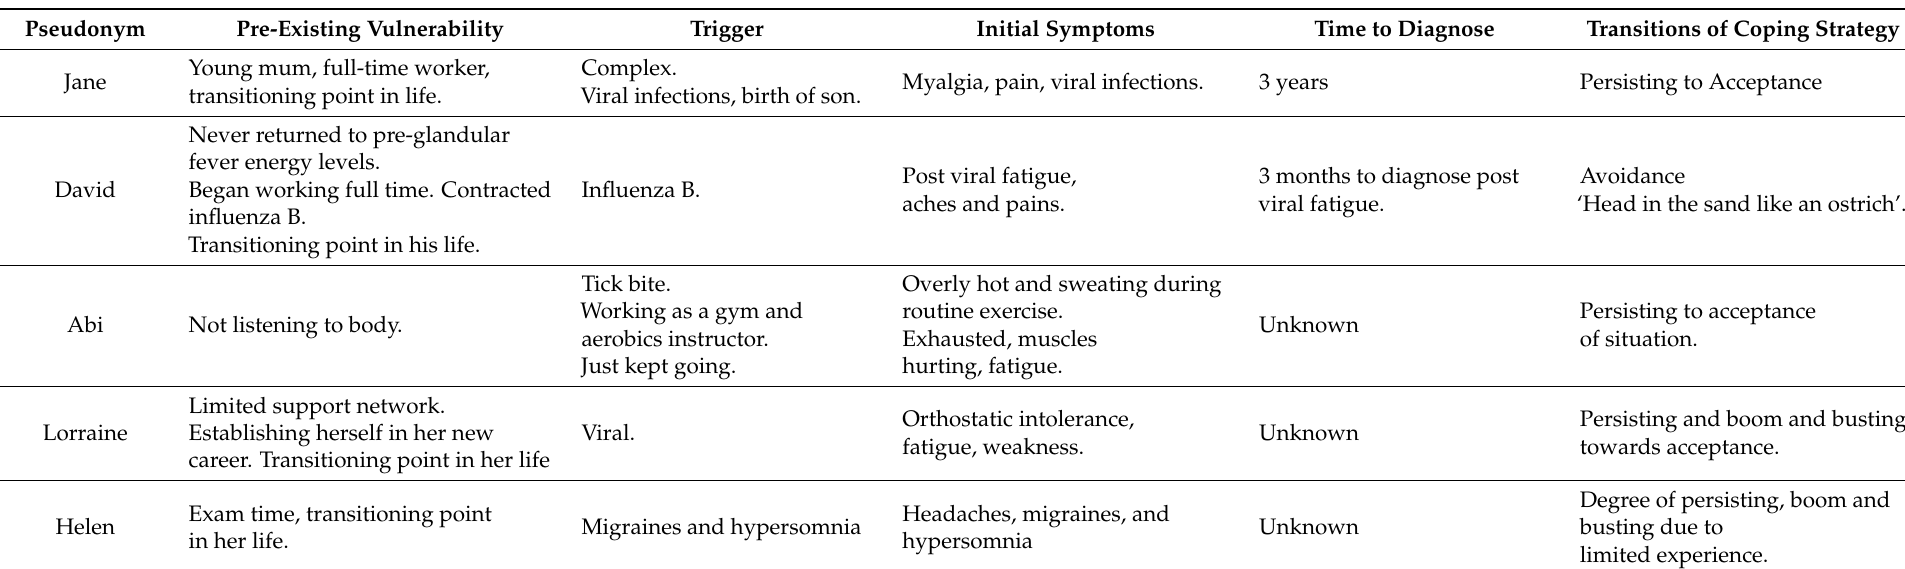
Table 3. Characteristics of early